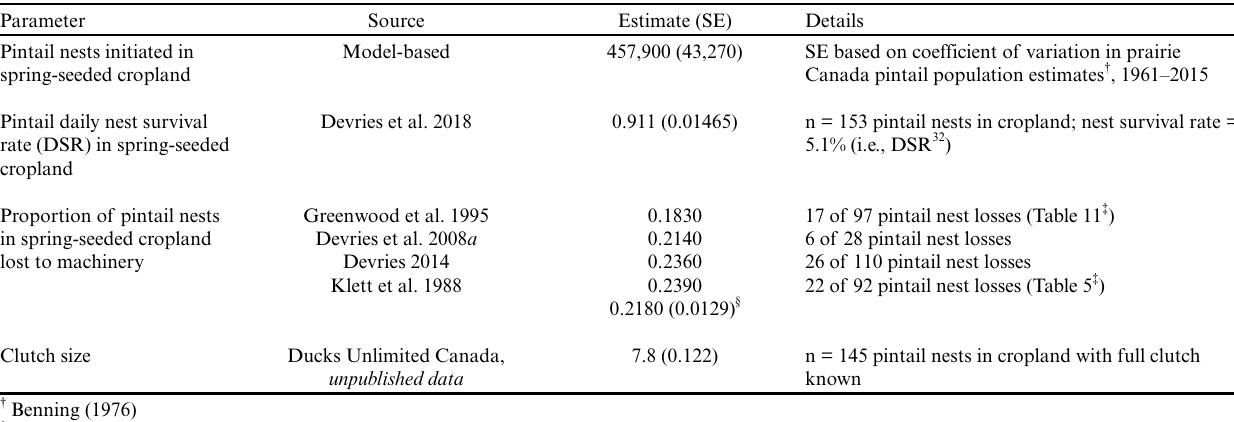
Table 2 . Parameter estimates and standard errors used in the calculation of Northern Pintail ( Anas acuta ) eggs lost to destruction by agricultural machinery annually in spring-seeded cropland in prairie